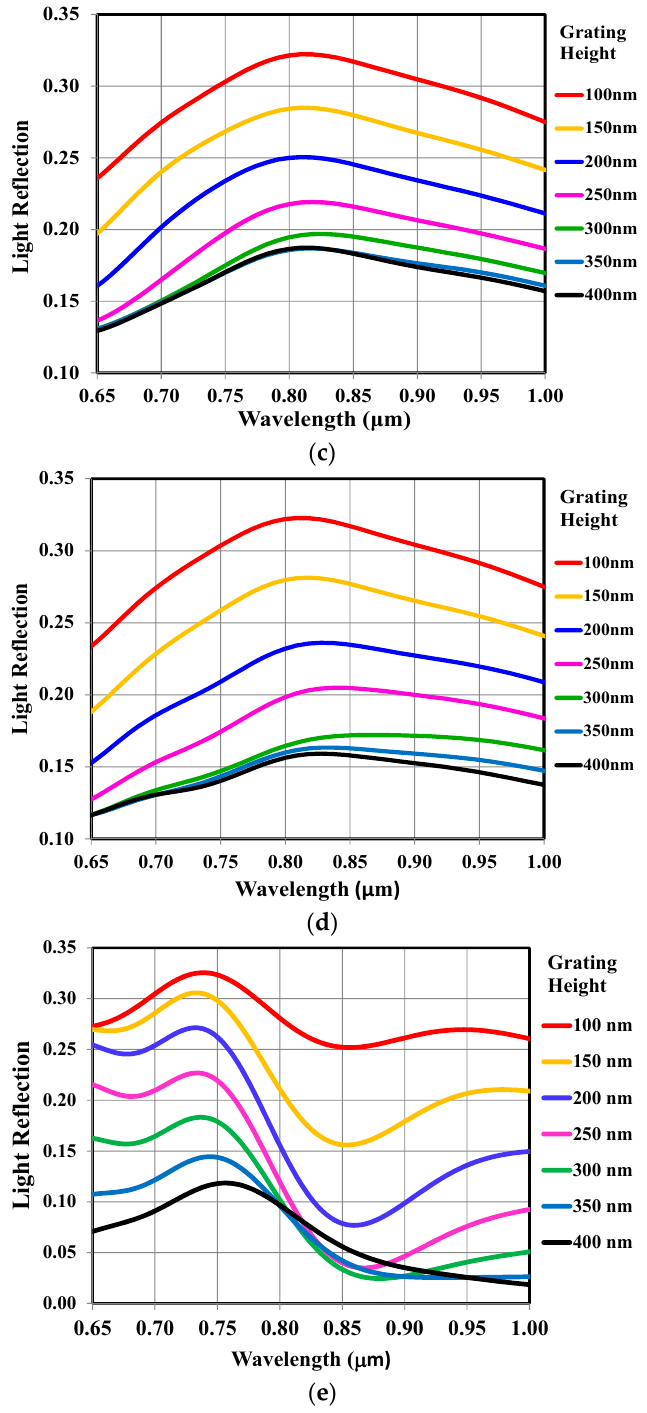
Figure 7. Light reflection spectra for several triangular ‐ or conical ‐ shaped nano ‐ grating heights with different pitch or period. The periods are: ( a ) triangular ‐ or conical ‐ shaped nano ‐ grating with pitch 200 nm; ( b ) triangular ‐ or conical ‐ shaped nano ‐ grating with pitch 300 nm; ( c ) triangular ‐ or conical ‐ shaped nano ‐ grating with a pitch 350 nm; ( d ) triangular ‐ or conical ‐ shaped nano ‐ grating with pitch 400 nm; and ( e ) triangular ‐ or conical ‐ shaped nano ‐ grating with pitch 830 nm. The incident light wavelength is kept constant at 830 nm.